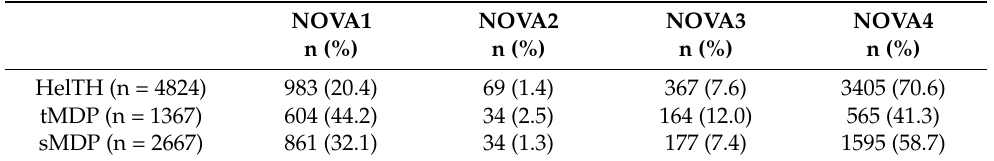
Table 1. Distribution of foods included in the traditional Mediterranean diet pyramid (tMDP), in the sustainable Mediterranean diet pyramid (sMDP), and, overall, the HelTH BFCD among the four groups of the NOVA classification